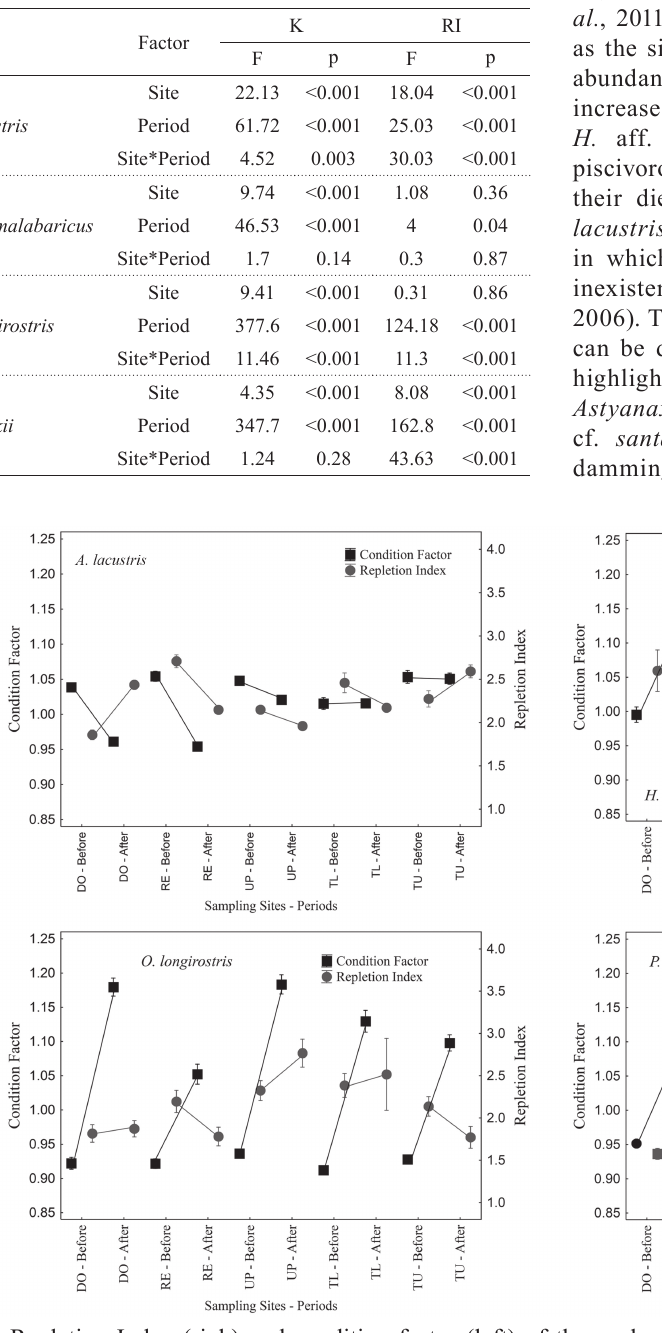
Fig. 4 . Repletion Index (righ) and condition factor (left) of the analysed species from Iguaçu River in the Salto Caxias Reservoir influence, before and after damming and sites (RE - reservoir region; DO - downstream; UP - upstream from the Iguaçu River; TL - tributaries lower section; TU - tributaries upper section). Vertical bars= standard